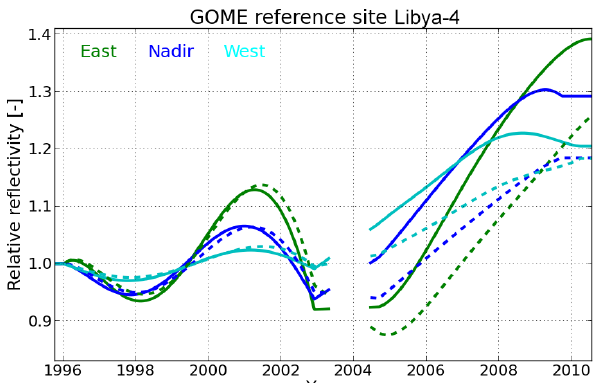
Figure 8. Relative reflectivity as a function of time for cloud-free GOME measurements at 325nm (solid) and at 335nm (dashed) for the Libya-4 reference site. Colours denote the different GOME pixel types: east (green), nadir (blue), and west (cyan) ground pixels. The data gap between mid-2003 and early 2004 is due to the ERS-2 on- board tape recorder failure in June